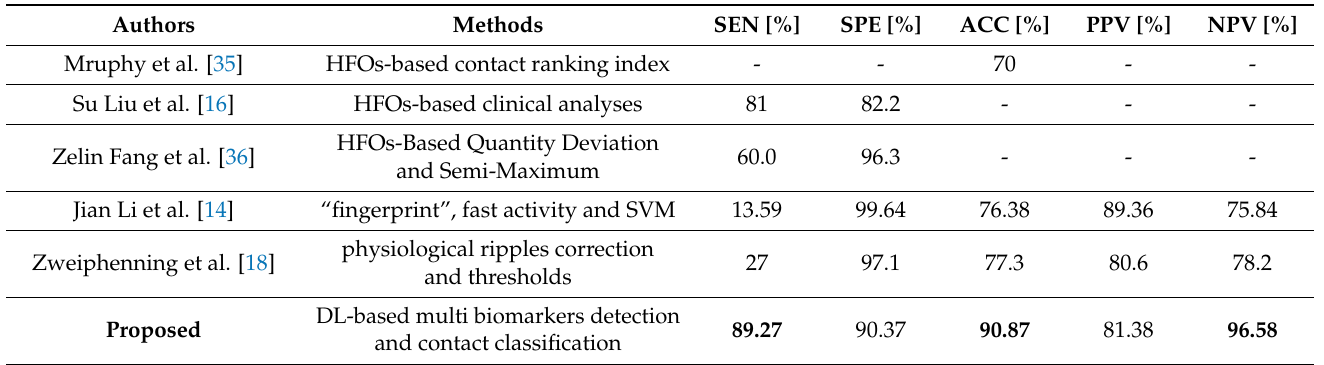
Table 8. Cross-subject validation of MEBM-SC and state-of-the-art